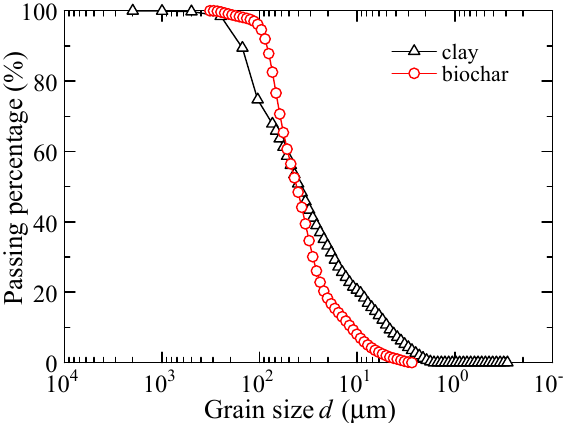
Figure 1. Grain − size distributions of the clay and biochar.